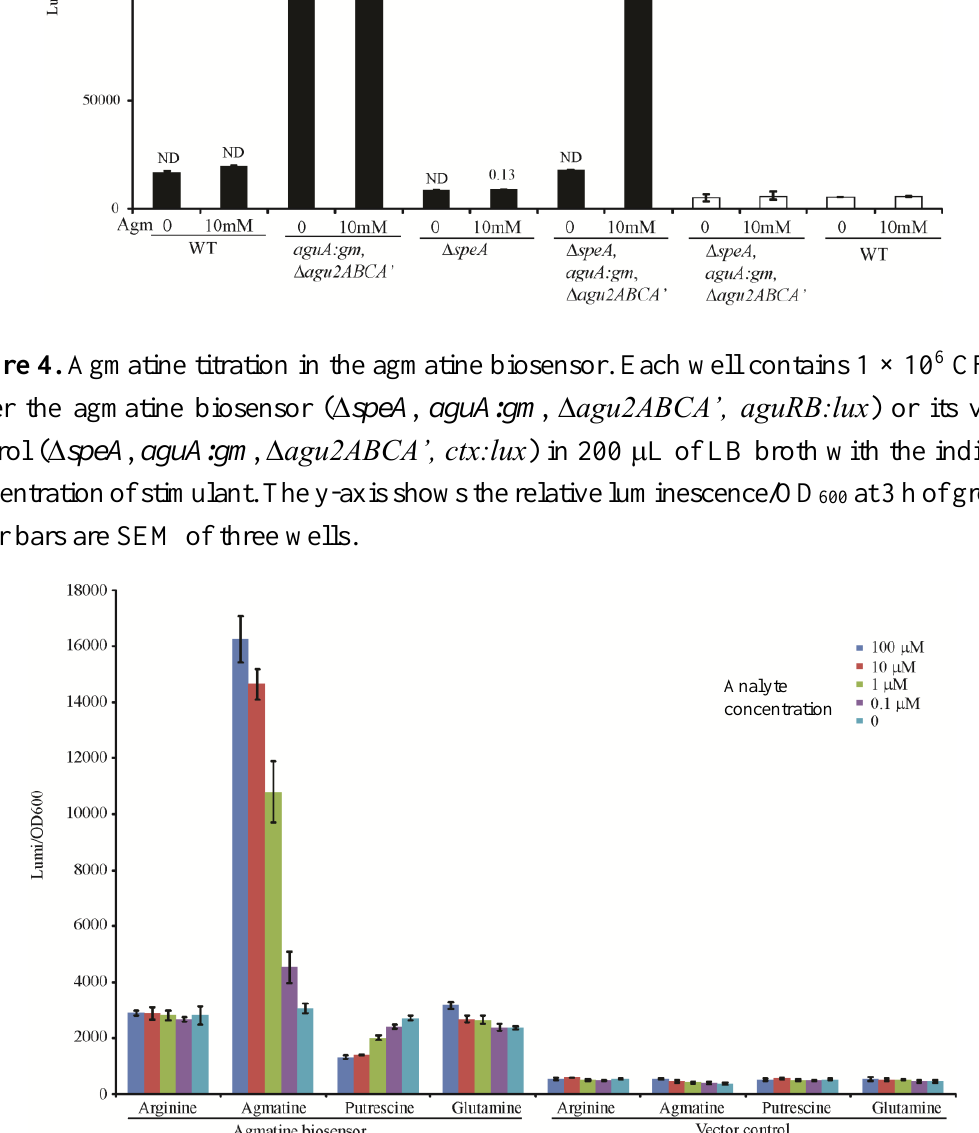
Figure 3. Agmatine response element behavior in mutants of the arginine decarboxylase and agmatine deiminase pathways. The agmatine “reporter construct” was inserted into the genomes of select mutant combinations in P. aeruginosa known to contribute to agmatine metabolism. Where indicated these mutant/reporter combinations were grown with or without agmatine. Filled boxes represent strains containing the aguRB-lux agmatine response element in their genomes, unfilled boxes contain the empty lux operon vector integrated into their genome. The y-axis represents relative luminescence/OD 600 of each well at 3 h of growth. Values above the filled bars are agmatine concentrations as determined by UPLC-MS/MS in micromolar. Error bars represent SEM of three wells. ND—none detected by mass spectrometry.